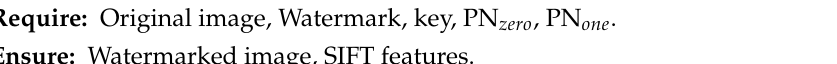
Algorithm 1 Watermark